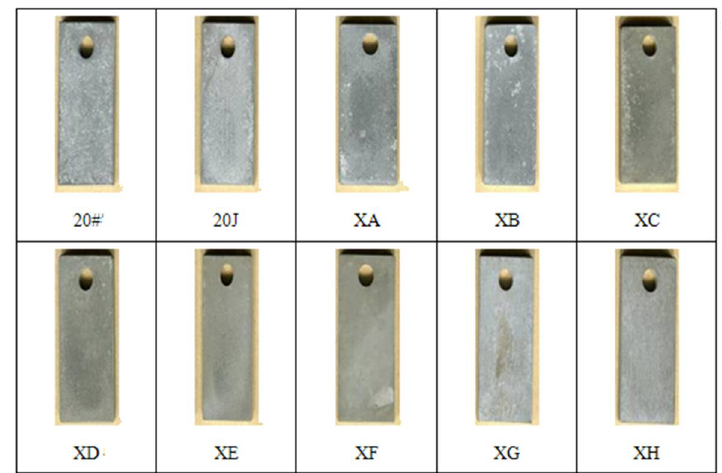
Figure 7. Morphology of coupons after the experiment.